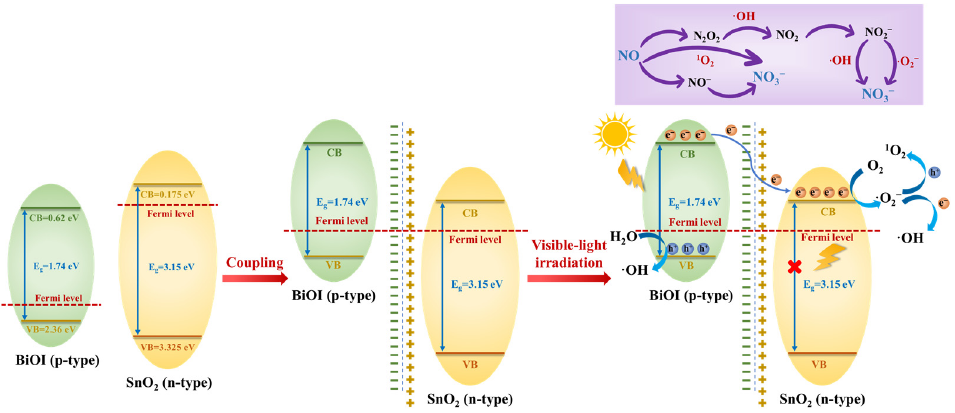
Figure 9. The proposed photocatalytic mechanism of NO oxidation by the BiOI/SnO 2 heterojunction.